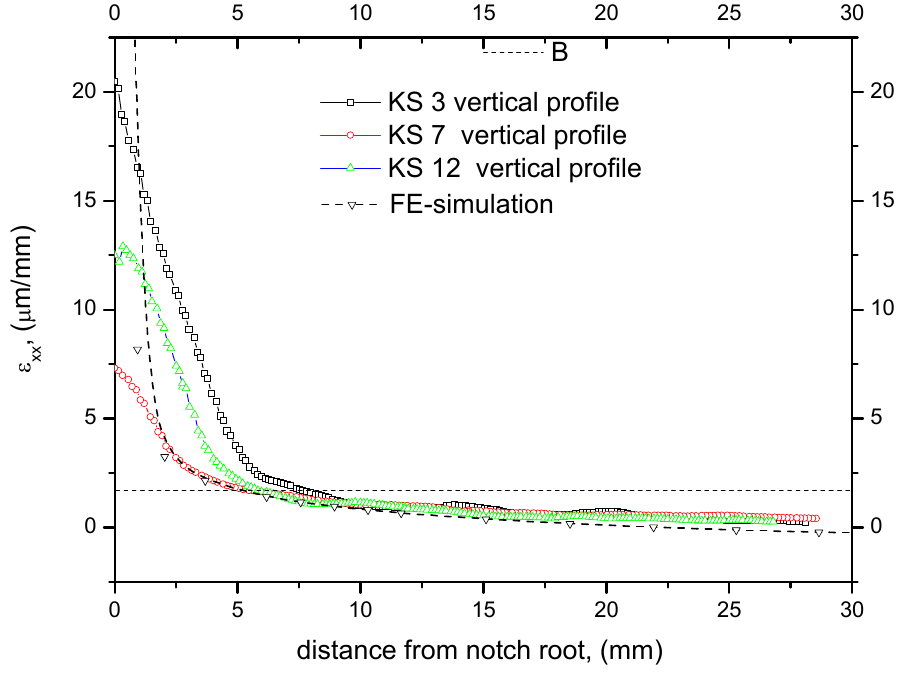
Figure 5. Vertical profile lines of e in crack growth direction from ESPI measurements xx and from simulation. Dashed horizontal line shows critical strain at failure onset. Fracture process zone length can be determined within 5 to 10 mm.